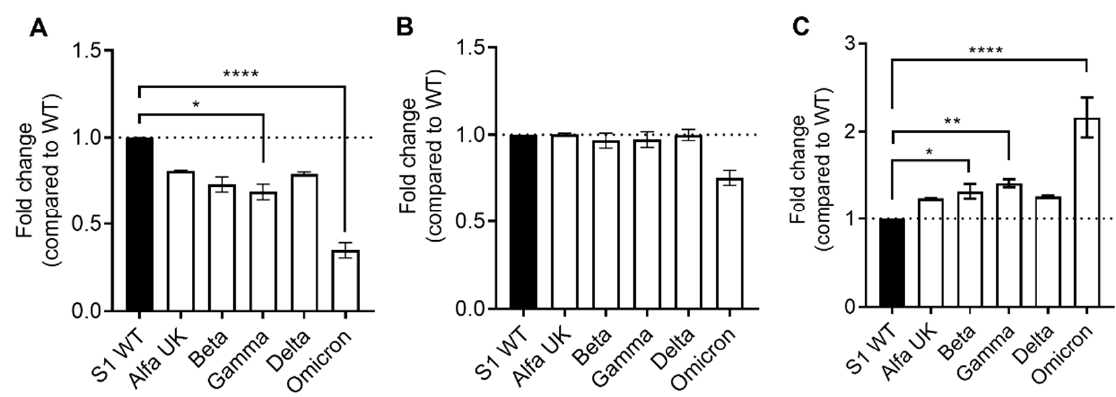
Figure 3. Fold change in SARS-CoV-2-specific IgG neutralization against VOCs (alfa UK, beta, gamma, delta, and omicron) normalized versus the wild type (WT) in uninfected ( A ) and recovered ( B ) vaccinated subjects at T4. ( C ) Comparison of fold change between the two analyzed groups at T4. Significance was determined using Dunnett’s multiple comparisons test; * p < 0.0332, ** p < 0.0021, **** p < 0.0001.